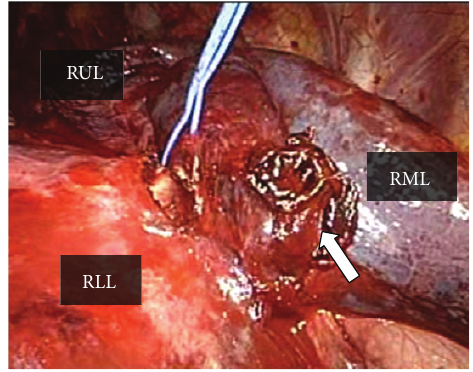
Figure 3: Intraoperative findings show pleural injury with a clotted hematoma in the middle lobe of the right lung (arrow). RUL: right upper lobe; RML: right middle lobe; RLL: right lower